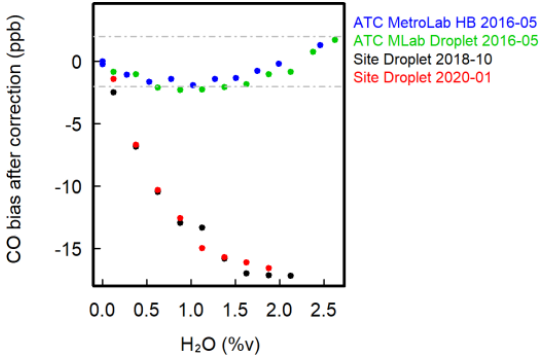
Figure 20. Example of water vapor correction assessment over time for CO. HB stands for humidity bench, while Droplet is for the droplet test described in the text. The humidity bench allows a much more controlled and precise sensitivity test. The two sites’ droplets show a large drift in the water vapor correction compared to the initial